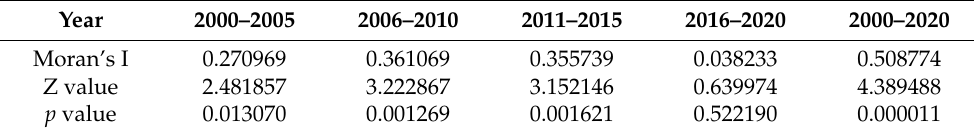
Table 4. Global spatial correlation coefficients at different